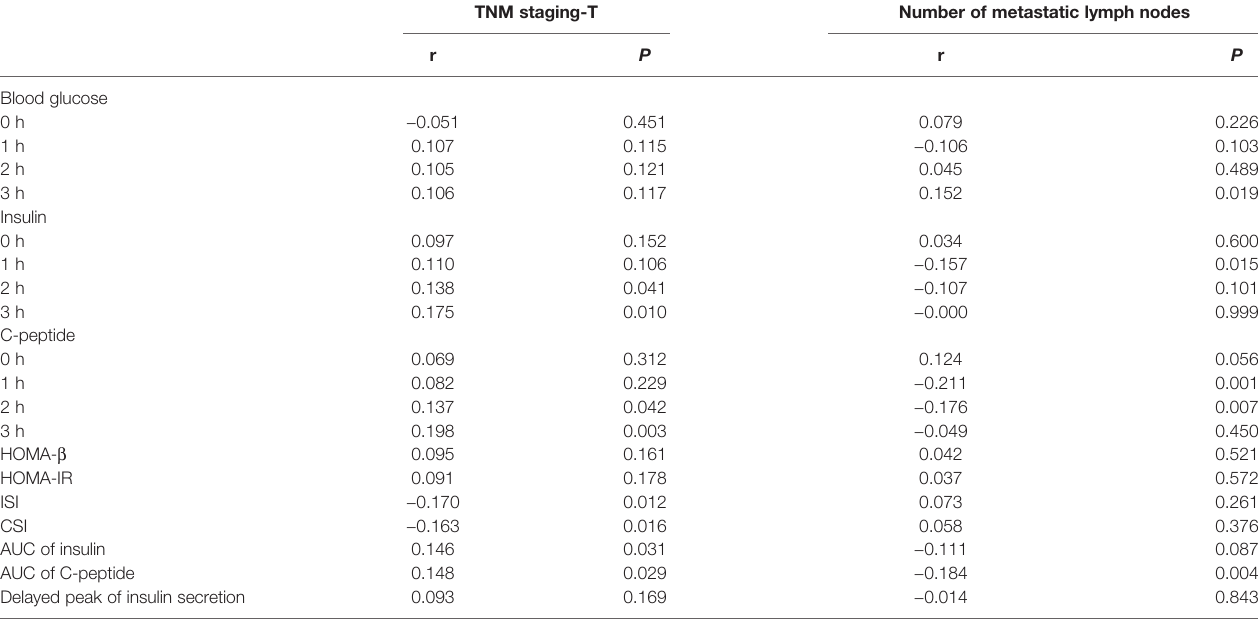
TABLE 4 | Spearman ’ s correlation analysis evaluating the association between glucose metabolism index and aggressiveness of DTC in all patients (TNM staging-T, number of metastatic lymph nodes and capsule invasion).